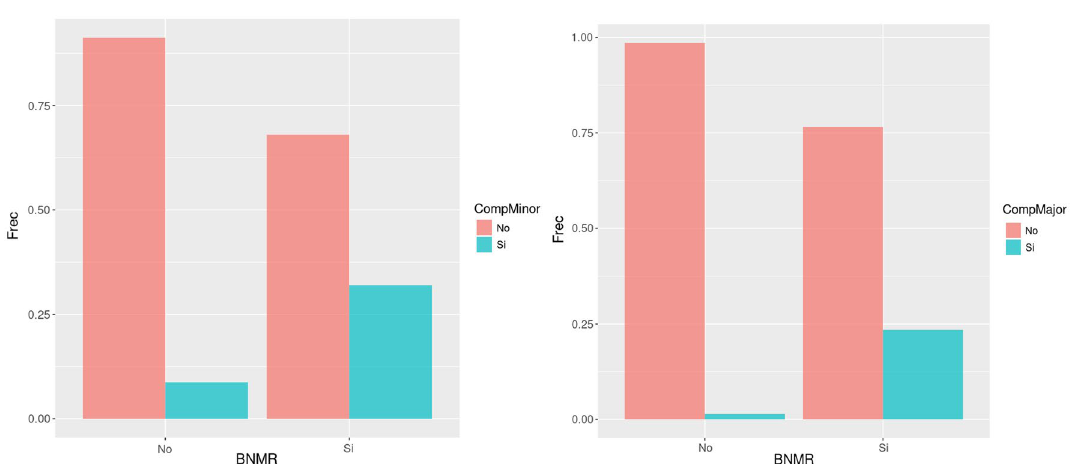
Figure 3. Comparison of early and late-onset postoperative pulmonary by the residual neuromuscular blockade. The figure illustrates the incidence of early and late-onset complications in our sample of patients, classified by the presence or absence of RNMB. Patients with RNMB had an incidence of early POPC of 32% and an incidence of late-onset complications of 23.50%. Patients without RNMB had an incidence of early complications of 8.75% and an incidence of late-onset complications of 1.36%. BNMR residual neuromuscular blockade, CompMinor early postoperative pulmonary complications, CompMajor late-onset postoperative pulmonary